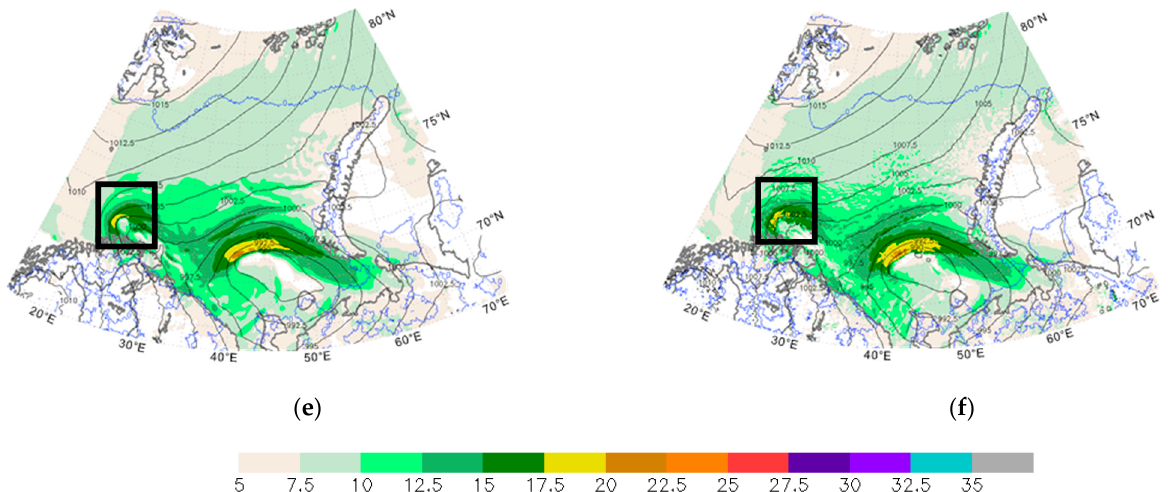
Figure 7. ICON-A6.5 (left), ICON-A2 (right): 10 m wind speed and sea-level pressure with lead times of 4 ( a , b ), 19 ( c , d ), and 29 h ( e , f ). Base time: 00:00 UTC 26 November 2019. Valid times: 04:00 UTC 26.11 ( a , b ), 19:00 UTC 26.11 ( c , d ), 05:00 UTC 27.11 ( e , f ). Black square shows the position of PL according to the satellite image.